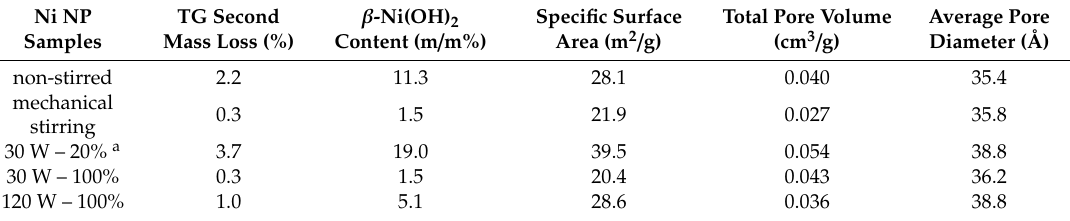
Table 2. The results of the thermogravimetric (TG) analysis and the N 2 adsorption-desorption measurements of the nickel nanoparticles.